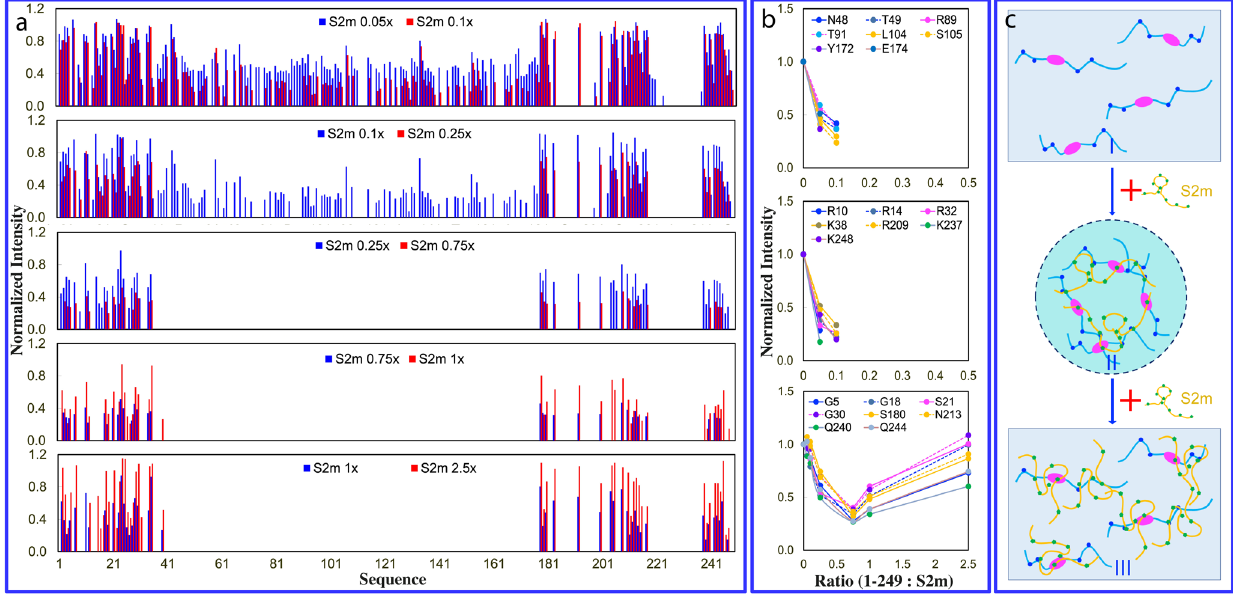
Fig. 4 Residue-speci fi c view of the biphasic modulation of LLPS of N (1-249) by S2m. a Normalized intensity of N (1-249) residues in the presence of S2m at different ratios as divided by that of N (1-249) residues without S2m. b Normalized intensity of three groups of N (1-249) residues in the presence of S2m at different ratios. c Speculative model of homogeneous solution of N (1-249) (I) which is induced to phase separate upon adding S2m at low ratios (II) followed by dissolution into homogeneous solution at high ratios